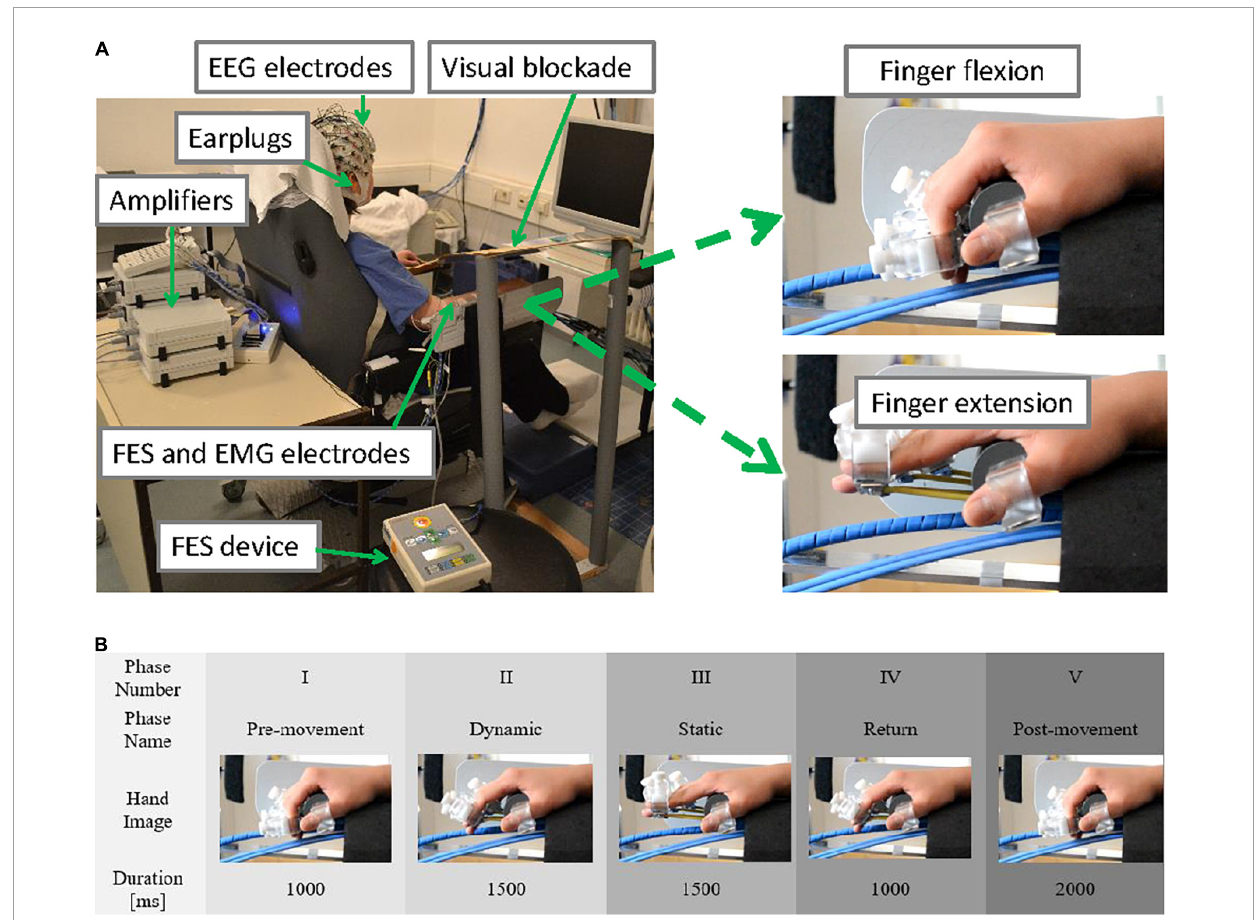
FIGURE1 (A) Experimental setup (upper panel). The participant was sitting in a comfortable chair with the EEG cap on, the EMG electrodes placed over the forearm and upper arm muscles while the right hand was strapped to a robotic hand orthosis, and a pair of FES electrodes were attached to forearm muscles (left). A visual blockade (to prevent the user from receiving visual feedback from her right-hand movement) and earplugs were used. The maximal range of passive finger flexion (top right) and finger extension (bottom right) are shown. (B) Time course of one trial (lower panel). No stimulus was provided during the pre-movement period (phase I at –1,000 ms). No cue was presented. The fingers were extended according to the experimental conditions (ORTHOSIS or ORTHOFES) to reach a full finger extension (phase II at 0 ms). During the finger stretched period, the finger position was maintained (phase III at 1,500 ms). During the return period (phase IV at 3,000 ms), the fingers were returned to the starting position by the orthosis alone in both conditions (ORTHOSIS and ORTHOFES). No stimulus was delivered during the Post-movement period (phase V at 4,000